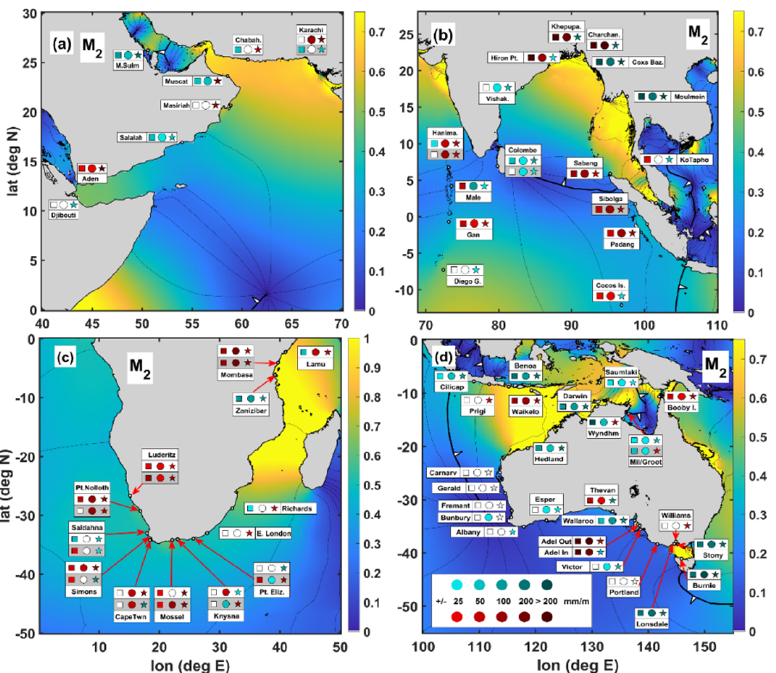
Figure 7. M 2 TACs in four different regions of the Indian Ocean: ( a ) the Arabian Sea, ( b ) the Bay of Bengal, ( c ) Africa, and ( d ) the Australian region. Symbols inside boxes indicate three different frequency bands: squares are the sub-annual (SA) band, circles are the annual (ANN) band, and stars are the interannual (IA) band. Station names are also indicated. Color shading of the symbols indicates positive (shades of red) and negative (shades of blue) TACs, according to the legend at bottom right. Background colors show tidal amplitudes (corresponding to the color bar at the right of each subplot in units of meters) and phases (solid lines, in increments of 30°) from the TPXO 7.2 global solution [374] . The figure is taken from [372] .